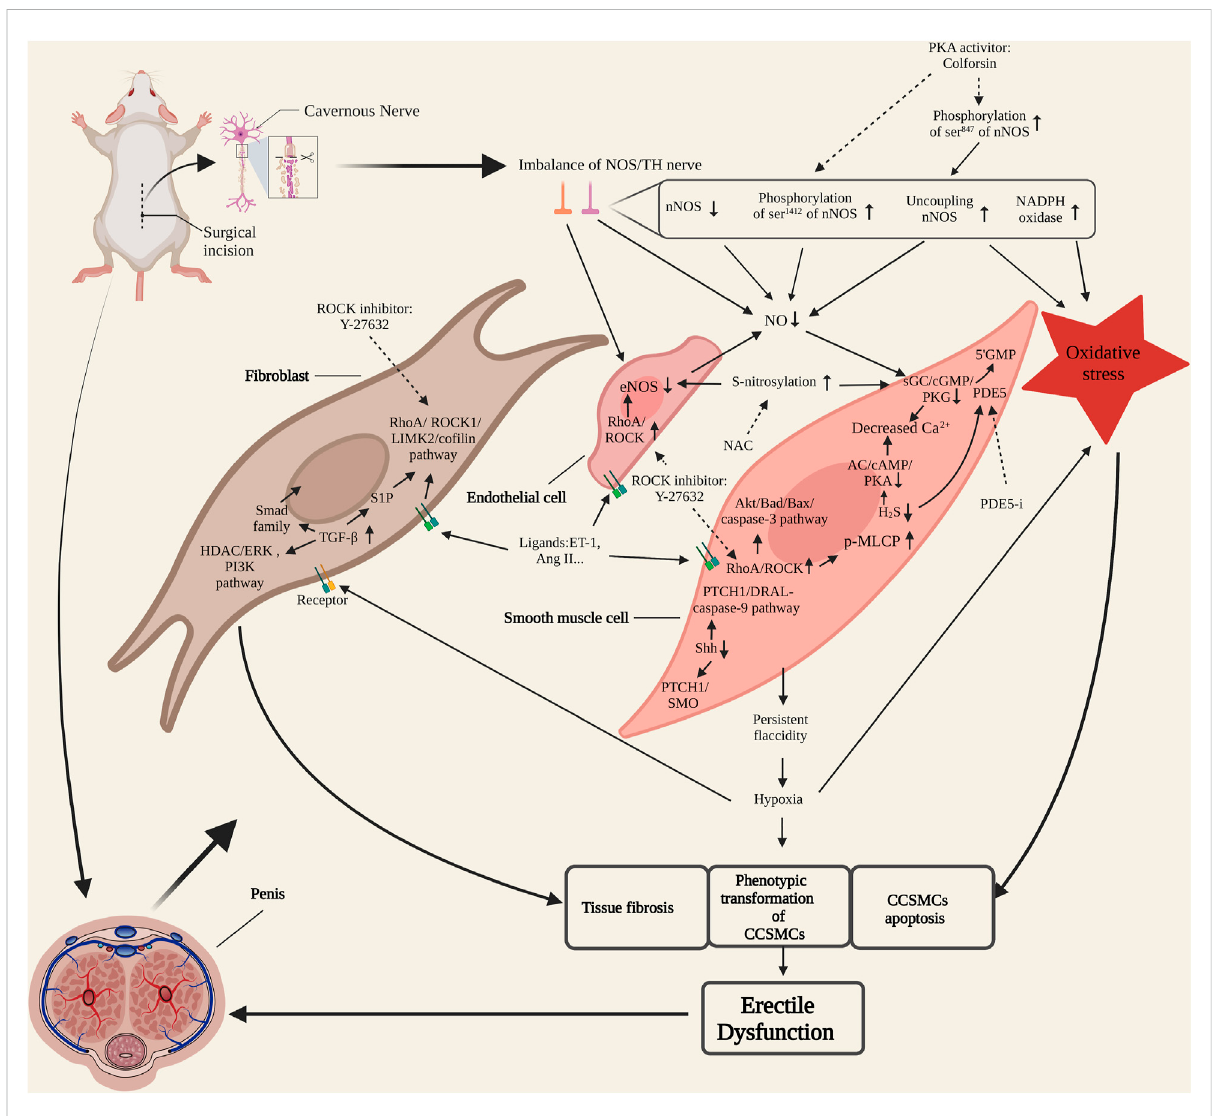
FIGURE 1 Molecular mechanism of cavernous nerve injury-erectile dysfunction (CNI-ED). NOS/TH nerve, nitrergic and sympathetic nerve. CCSMCs, corpora cavernosum smooth muscle cells; NOS, nitric oxide synthase; PKA, protein kinase A; NO, nitric oxide; sGC, soluble guanylate cyclase; PKG: cGMP-speci fi c protein kinase; PDE5, phosphodiesterase type 5; PDE5-i, phosphodiesterase type 5 inhibitor; AC, adenylate cyclase; NAC, N-acetyl- cysteine;ET-1,endothelin;AngII,angiotensinII;TGF- β ,transforminggrowthfactor- β ;S1P,sphingosine-1-phosphate.Dottedarrowrepresents